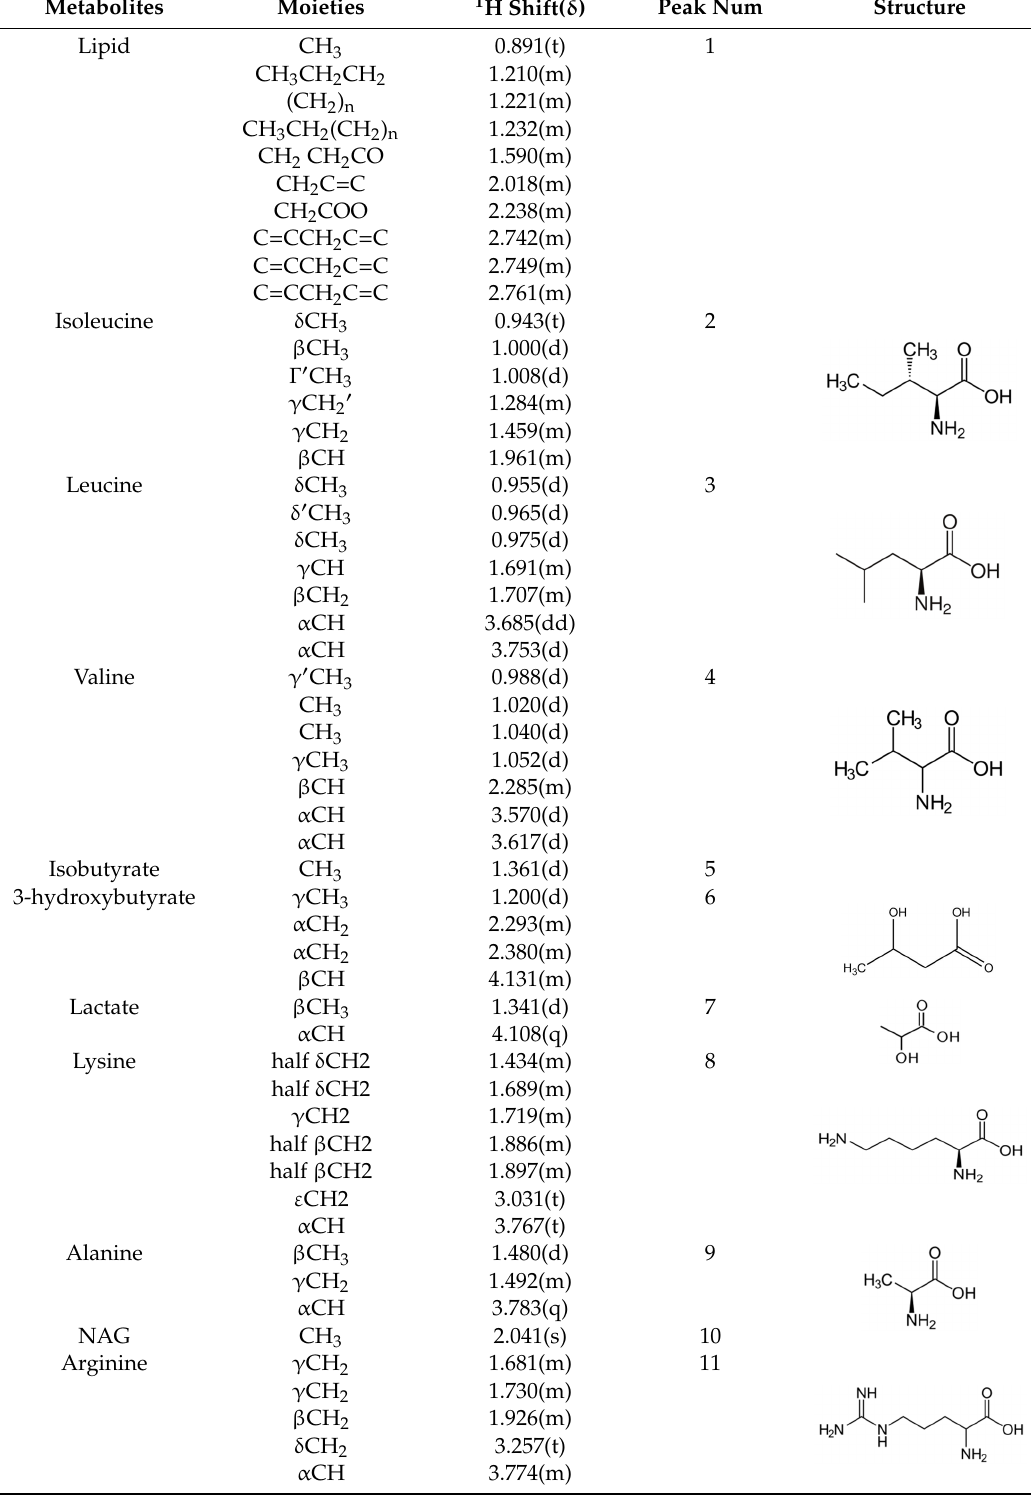
Table 2. The NMR related information of the related proton signals in the small molecules in the serum samples.